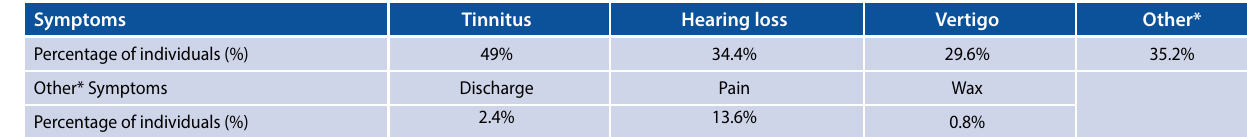
* Other refers to symptoms experienced not as a result of ototoxicity from medication used.